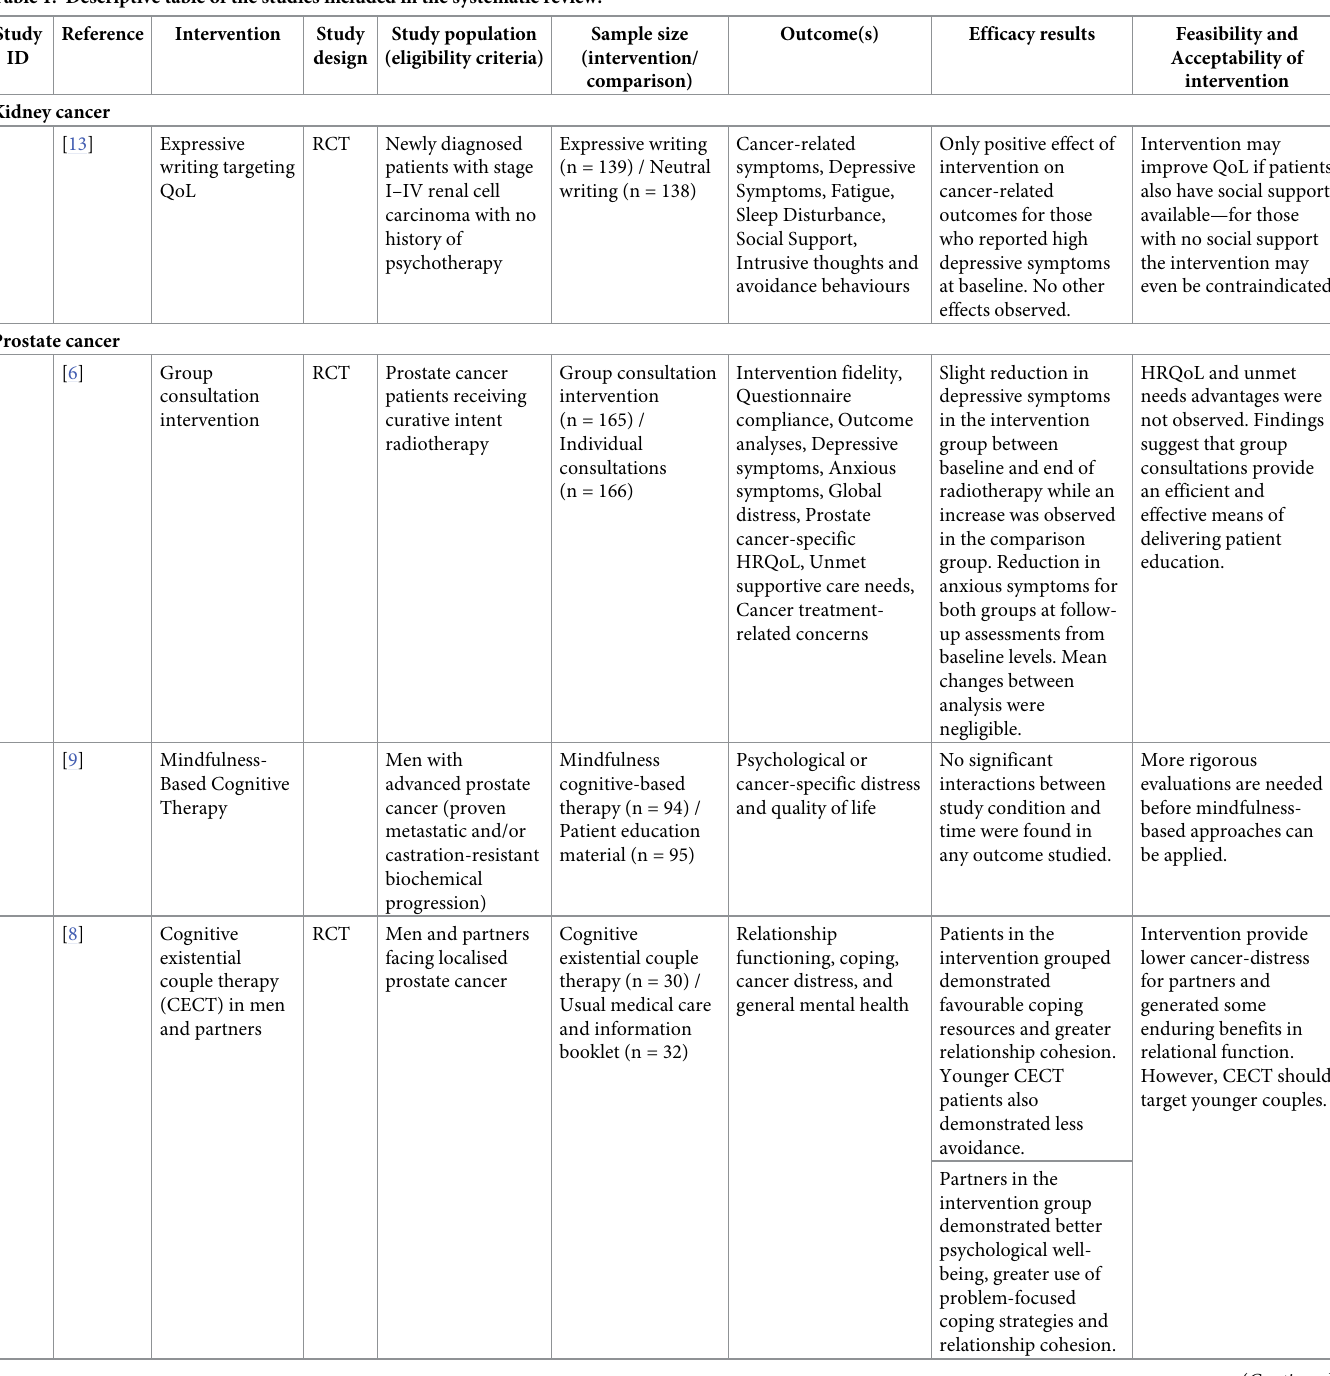
Table 1. Descriptive table of the studies included in the systematic